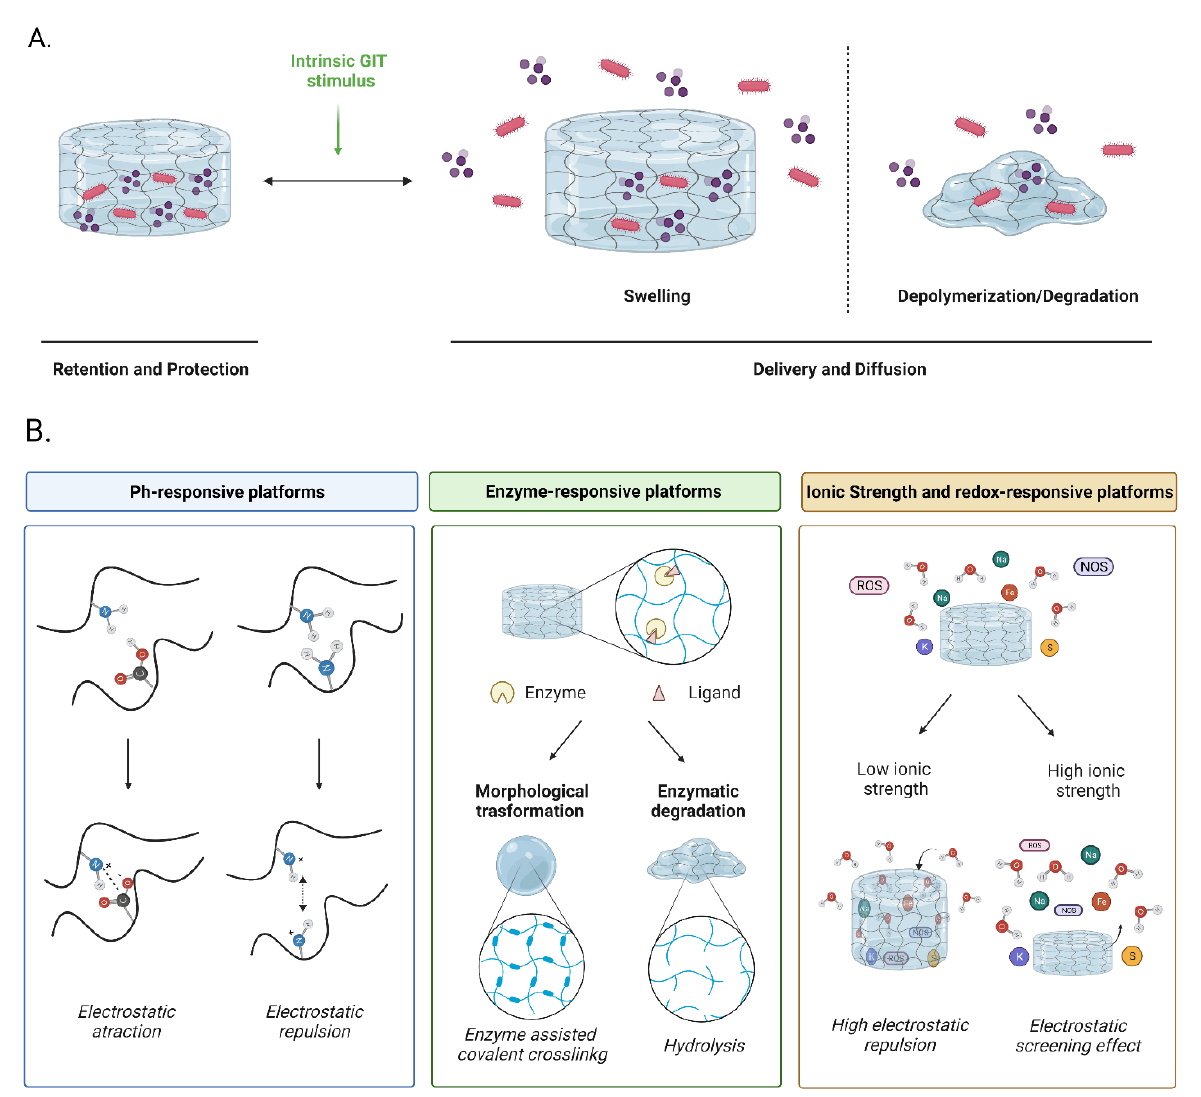
Figure 2. Schematic of stimuli-responsive matrices to approachable GIT stimulus. ( A ) General stimuli-driven conformational changes of polymeric platforms. ( B ) Mechanism of physicochemical changes of stimuli-responsive platforms by intrinsic pH changes, enzymatic action, ionic strength, and potential redox changes.